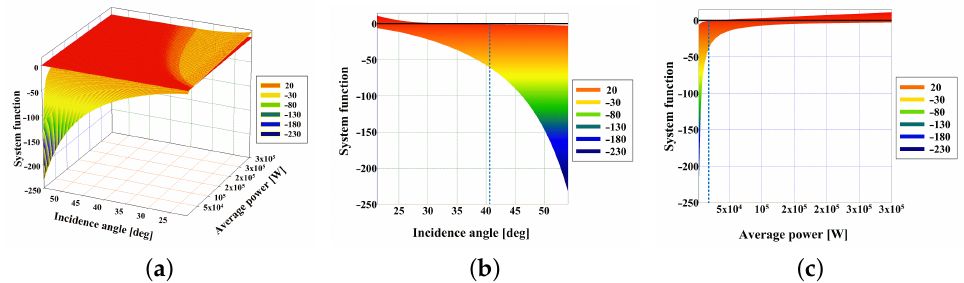
Figure 4. ( a ) When the number of multi-looks and the satellite height are L look = 10 and H sat = 100 km, the system function changes with the incidence angle φ and average power P av . ( b , c ) are the simulation results of the system function changing with φ and P av , separately.